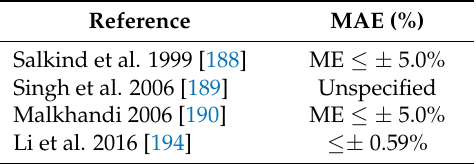
Table 18. MAE/ME of the FL-based SOC estimation